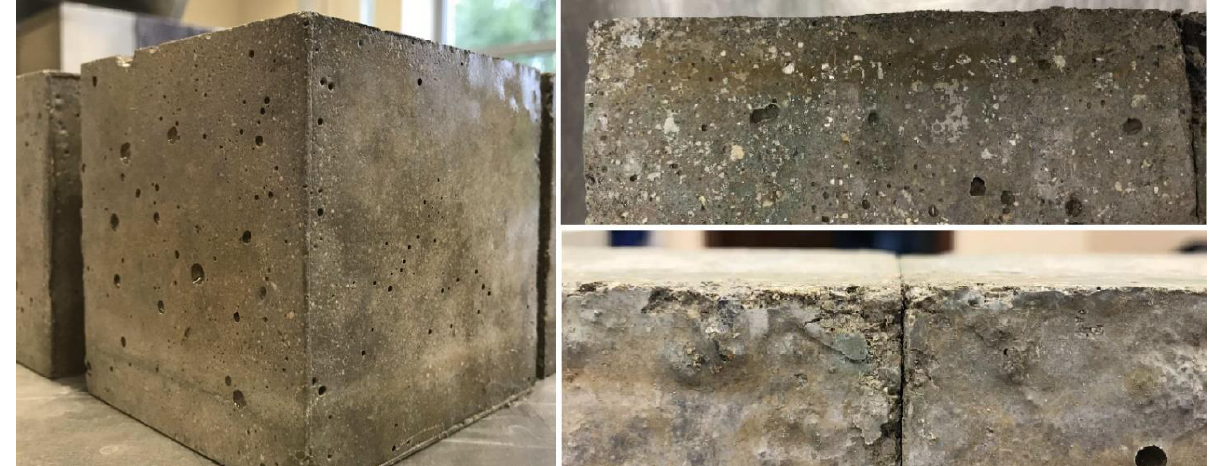
Figure 12. Surfaces of specimens after freezing/thawing cycles.